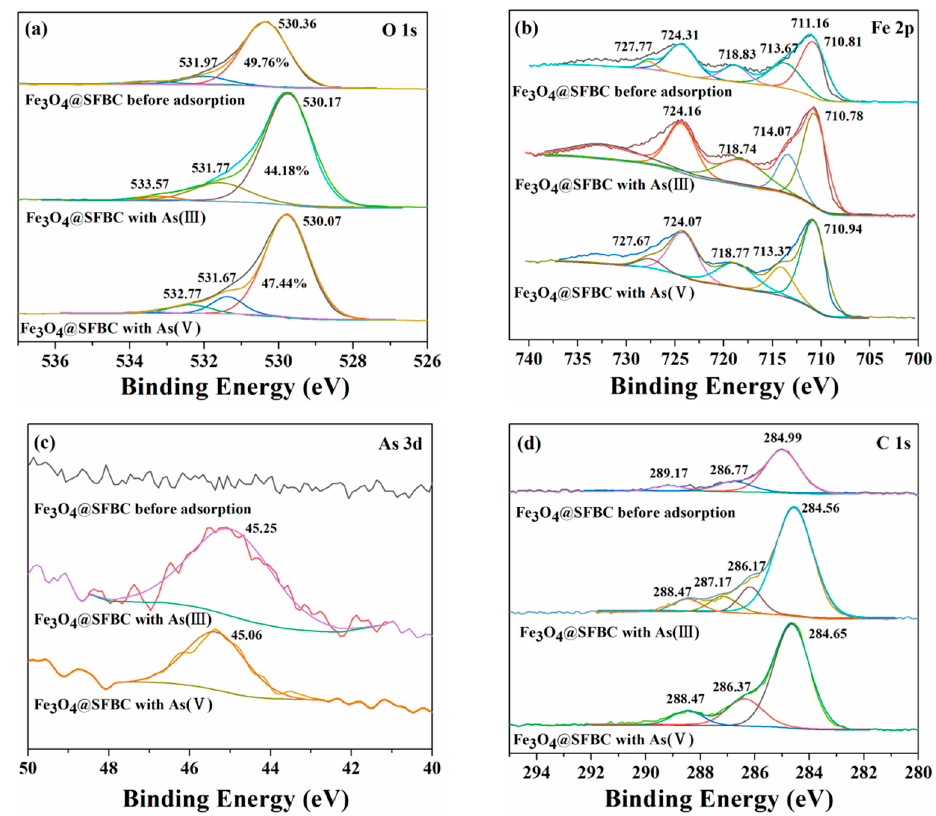
Figure 12. XPS spectra of Fe 3 O 4 @SFBC before and after arsenic adsorption: O 1s ( a ), Fe 2p ( b ), As 3d ( c ), C 1s ( d ).